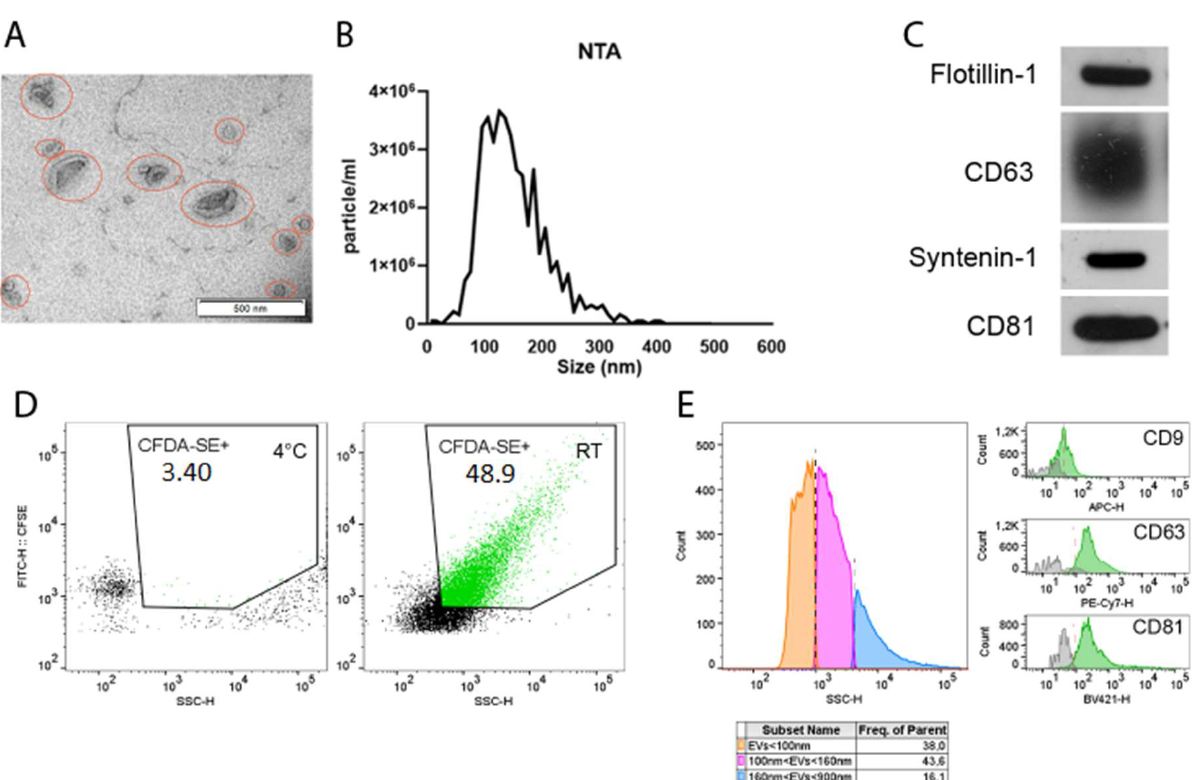
Figure 3. Extracellular vesicles’ characterization: ( A ) TEM micrographs of P3 regularly fed hBM- MSC-derived EVs (red circles). ( B ) Nanoparticle tracking analysis showing the size distribution of P3 regularly fed hBM-MSC-derived EVs. ( C ) Immunoblot analysis of P3 regularly fed hBM- MSC-derived EVs. Specific expressions of CD63, CD81, flotillin-1 and syntenin-1 were investigated. ( D ) CFDA-SE staining by non-conventional flow cytometry. Left panel shows the 4 ◦ C control. Right panel shows CFDA-SE staining at RT. Green areas identify CFDA-SE positive events. ( E ) Size distribution of EV subtypes. Three-dimensional gates were considered: EVs ≤ 100 nm (orange), 100 nm ≤ EVs ≤ 160 nm (pink) and 160 nm ≤ EVs ≤ 900 nm (blue). Right panels show CD9, CD63 and CD81 positive events falling within the CFDA-SE gate. Data are representative of at least three independent experiments. Abbreviations: nanoparticle tracking analysis (NTA); human bone marrow mesenchymal stem/stromal cells (hBM-MSC); extracellular vesicles (EVs); transmission electron microscope (TEM); nanoparticle tracking analysis (NTA); cluster of differentiation (CD); carboxyfluorescein diacetate succinimidyl ester